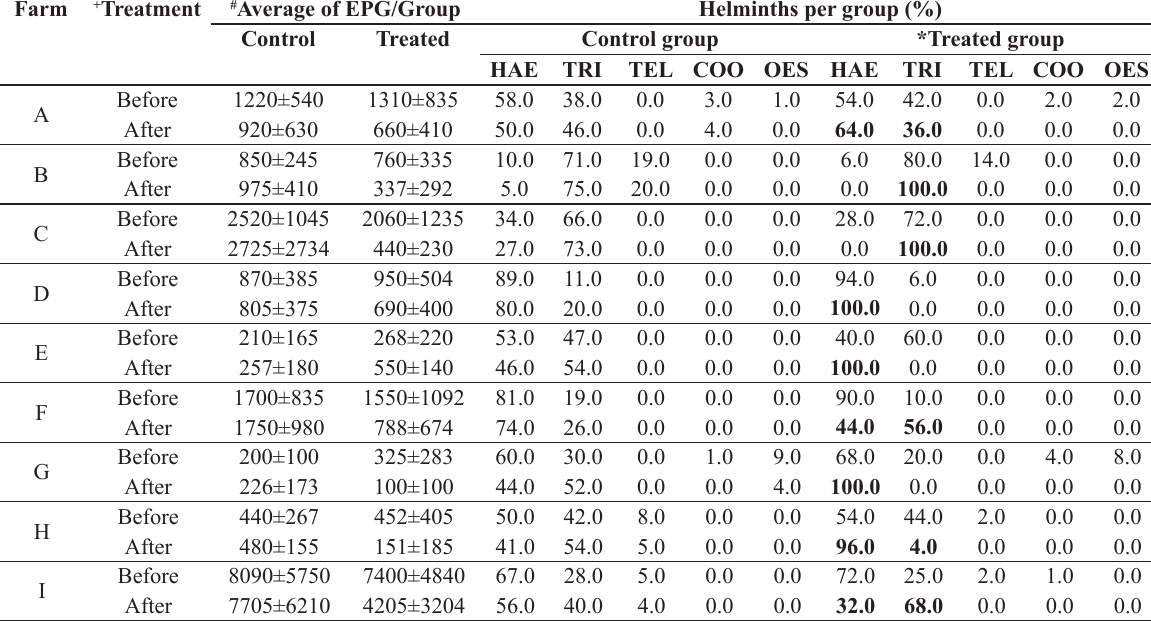
Average number of eggs per gram of feces (EPG) and percentage of helminthes ( Haemonchus [HAE], Trichostrongylus [TRI], Teladorsagia [TEL], Cooperia [COO] and Oesophagostomum [OES]) present in fecal samples from sheep before and after anthelmintic treatment with closantel (Farms A and B), levamisole